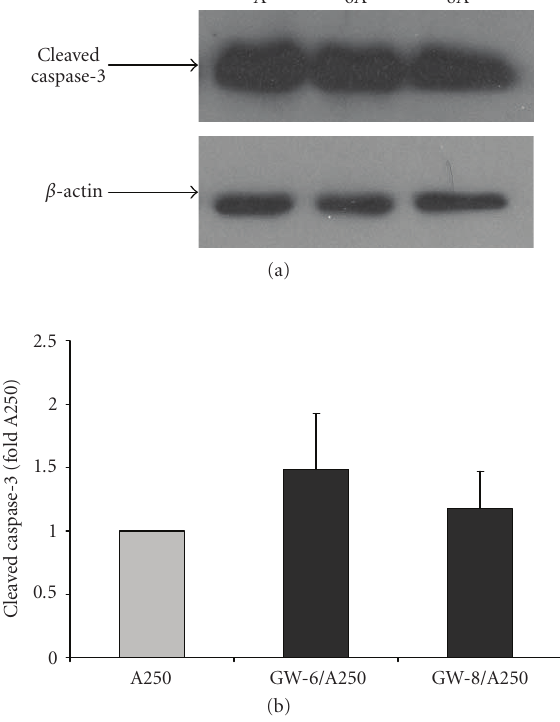
Figure 10: Pretreatment with GW501516 does not signifi- cantly alter anisomycin-induced cleaved caspase-3 protein in IMCD-K2 cells. Protein was isolated from IMCD-K2 cells that had been treated with control serum-free media, 10 − 6 or 10 − 8 M GW501516, 250 ng/mL anisomycin (A250 or A) for 24 hours, 10 − 6 M GW501516 for 3 hours pretreatment followed by 10 − 6 M GW501516 for 24 hours with A250 (GW-6/A250), or 10 − 8 M GW501516 for 3 hours pretreatment followed by 10 − 8 M GW501516 for 24 hours with A250 (GW-8/A250). (a) The lysates were run on an SDS-PAGE gel and incubated with an anticleaved caspase-3 antibody (1 : 1000). (b) The membranes were stripped and incubated with anti- β -actin antibody (1 : 10000) to normalize for densitometry. Expression is presented as fold A250. Values are mean ± S.E.M.; n =